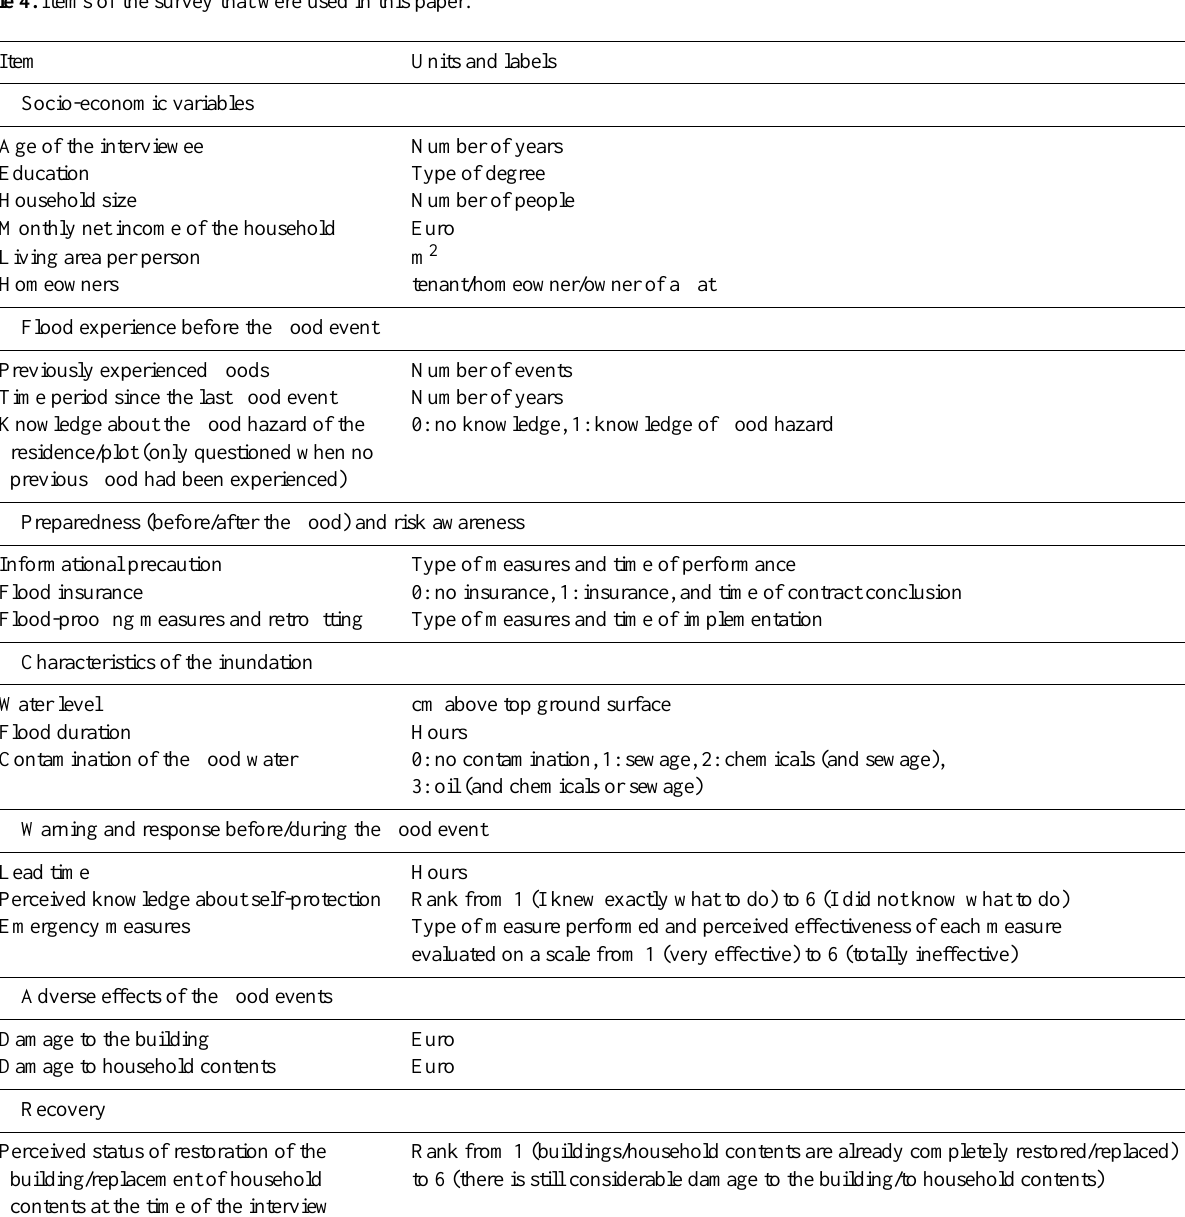
Table 4. Items of the survey that were used in this paper. Item Units and